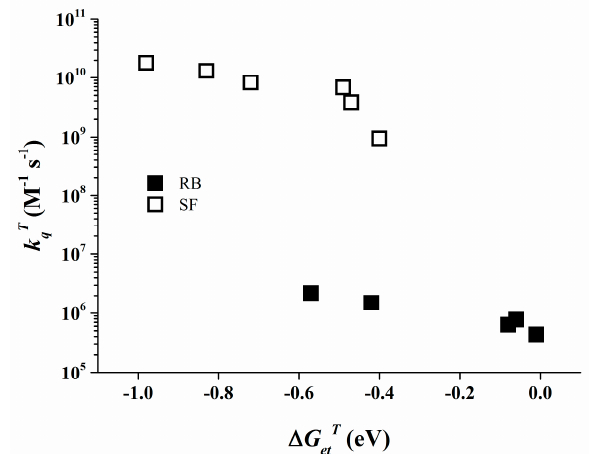
Figure 7. Quenching rate constant k qT of RB (filled symbols) and of SF (open symbols) as a function of ∆ G etT for different borate salts [35].